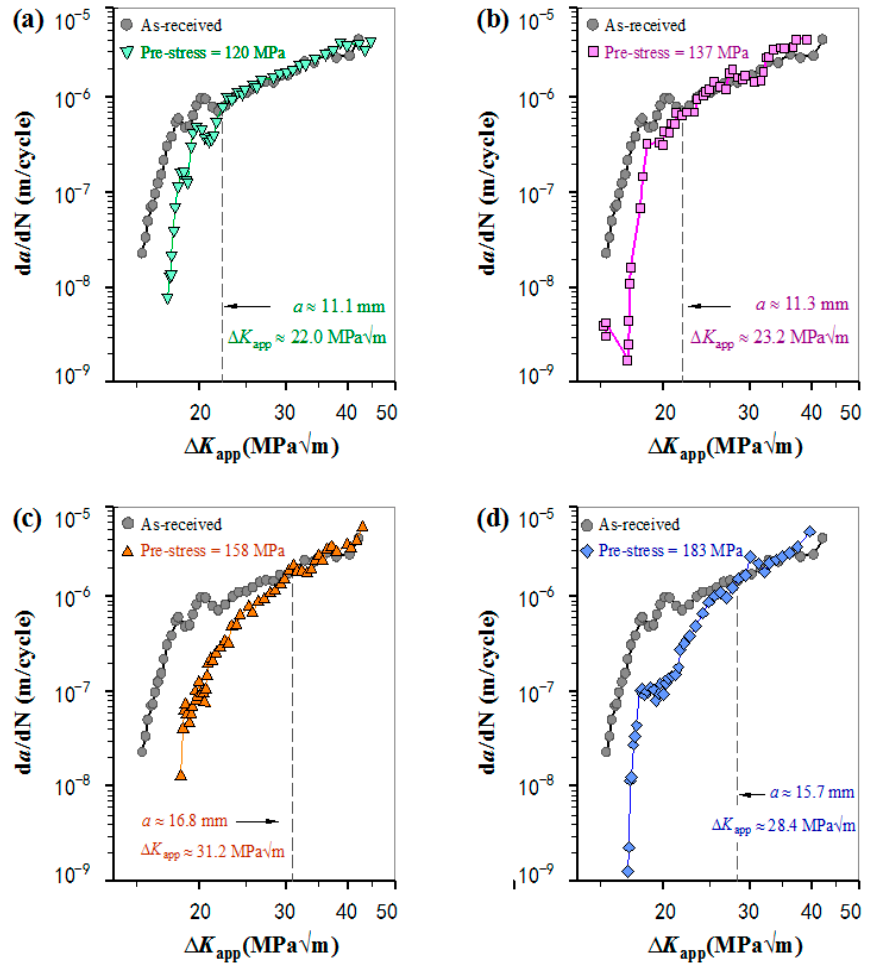
Figure 3. The da/dN- Δ K app curves for the comparison between the diverse pre-stress specimens and the as-received specimen: ( a ) the as-received specimen and the specimen with pre-stress = 120 MPa; ( b ) the as-received specimen and the specimen with pre-stress = 137 MPa; ( c ) the as-received specimen and the specimen with pre-stress = 158 MPa; and ( d ) the as-received specimen and the specimen with pre-stress = 183 MPa.